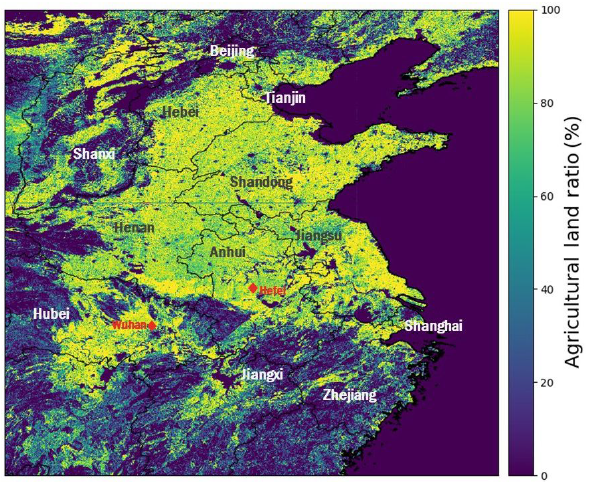
Figure 1. The spatial extent of the study area (111–123 ◦ E, 27– 40 ◦ N). The agricultural land ratio taken from the GlobeLand30 land cover product (Chen et al., 2015) was regridded to 0.01 ◦ spatial resolution and is overlain with the main provinces, megacities, and some important provincial capital cities in eastern China. The ba- sic layer of country–province borders within this map was created using the Python Basemap